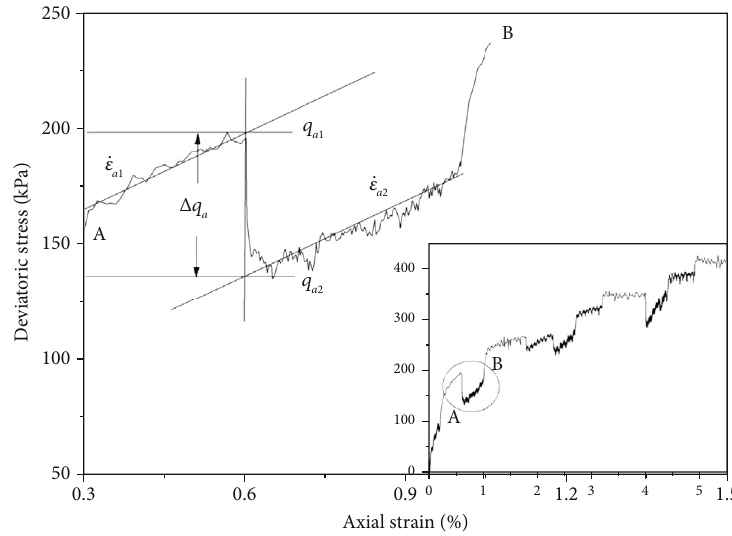
_ ε q q a 1 , and a , a 1 , a 2 ,